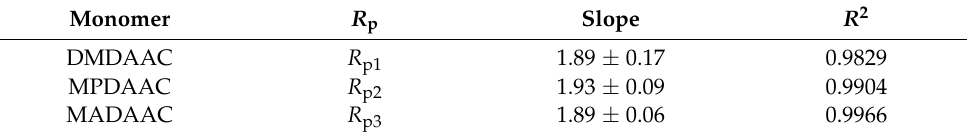
Figure 4. Relationship between lg R p and lg [ M ]. Table 3. Experimental results of fitting curve slopes of lg R p versus lg [ M ] of different monomers.